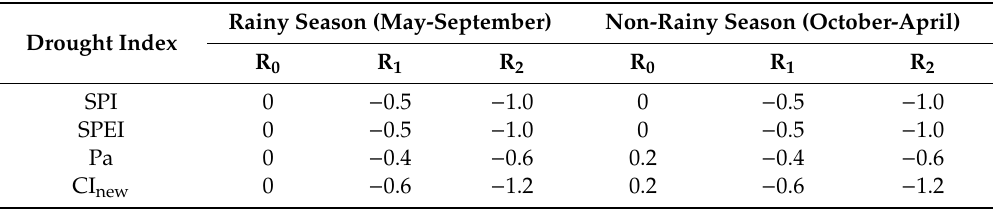
Table 4. Drought identification threshold of the SPI, SPEI, Pa and CI new .